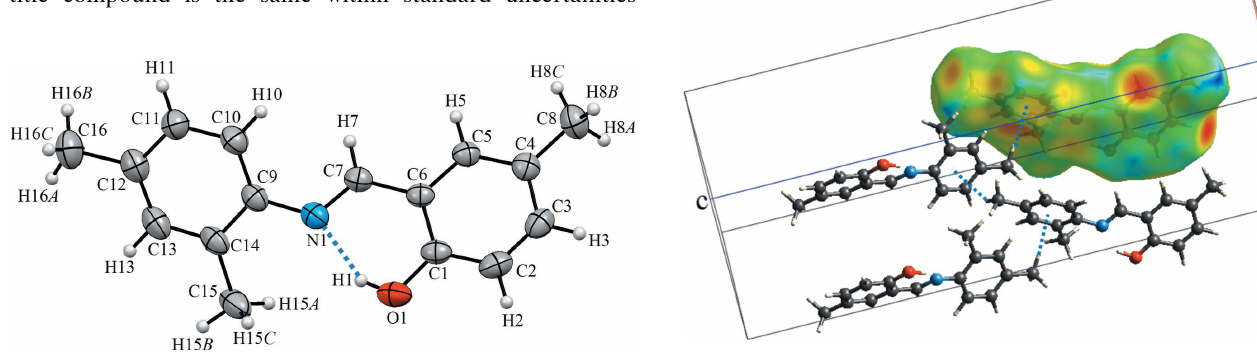
Figure 2 A view of the crystal packing of the title compound. The C16— H16 A (cid:2)(cid:2)(cid:2) Cg 2 interactions are denoted as dashed lines and as a red spot on the d e surface.